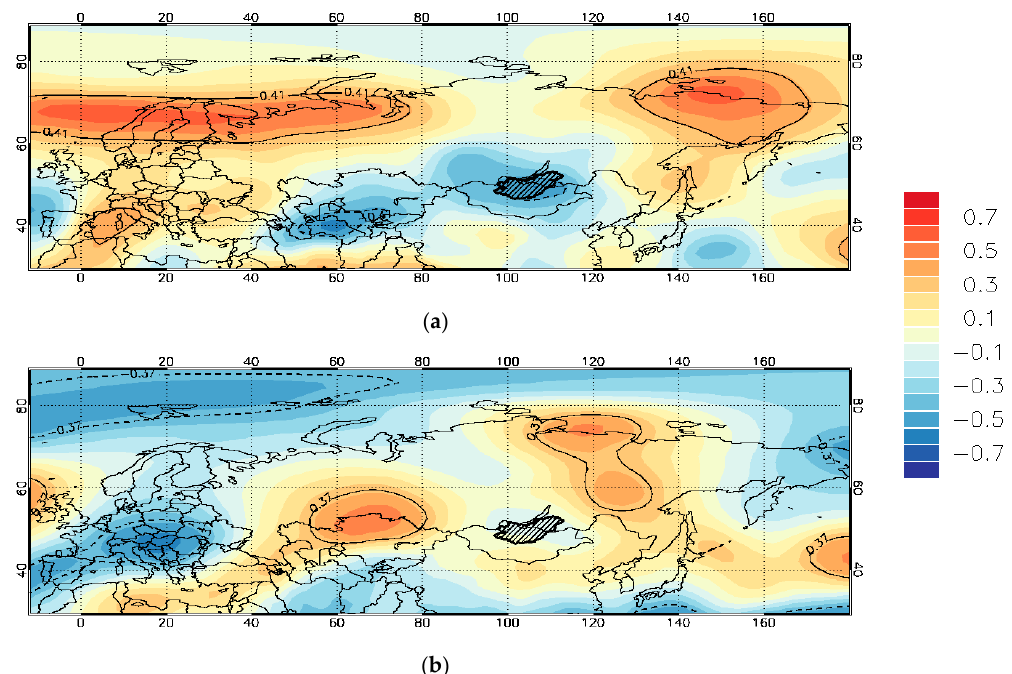
Figure 11. Correlation coefficients between TRPS and geopotential height at 500 hPa (Z500) for 1979–1995 ( a ) and 1996–2016 ( b ). The description is the same as in Figure 8.